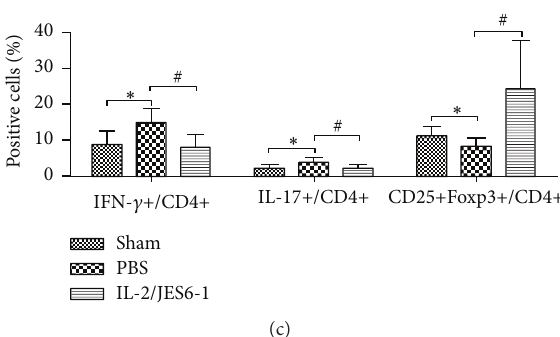
Figure 3: The IL-2/JES6-1 complex increases Treg cells and reduces Th1/17 cells. Splenocytes from 14 days after MI mice were stimulated with PMA/ionomycin/monensin, and CD4+IFN- 𝛾 + (Th1) or CD4+IL-17+ (Th17) cells among CD4+ Foxp3 − T cells were determined by intracellular staining for IFN- 𝛾 + or IL-17, respectively, as described in Section 2. Quantification of percentage of CD4+IFN- 𝛾 + cells and CD4+IL-17+ cells was analyzed by Flow Jo software. ∗ 𝑃 < 0.05 versus the Sham group; # 𝑃 < 0.05 versus the PBS